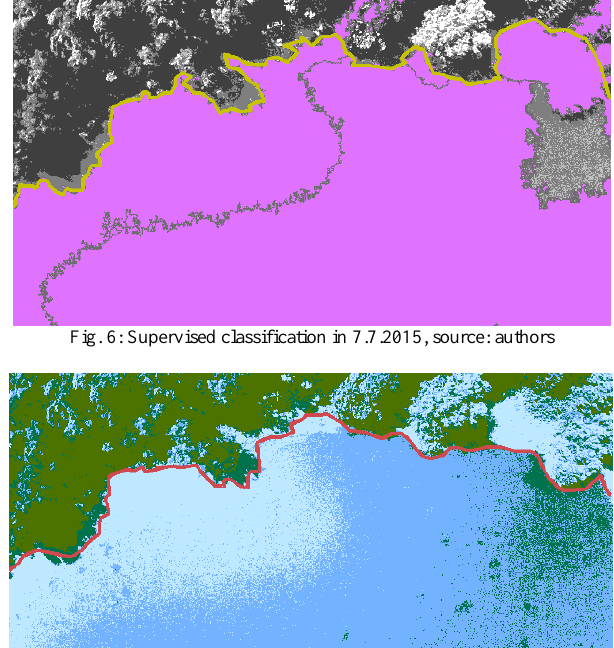
Fig. 7: Unsupervised classification in 7.7.2015, source: authors